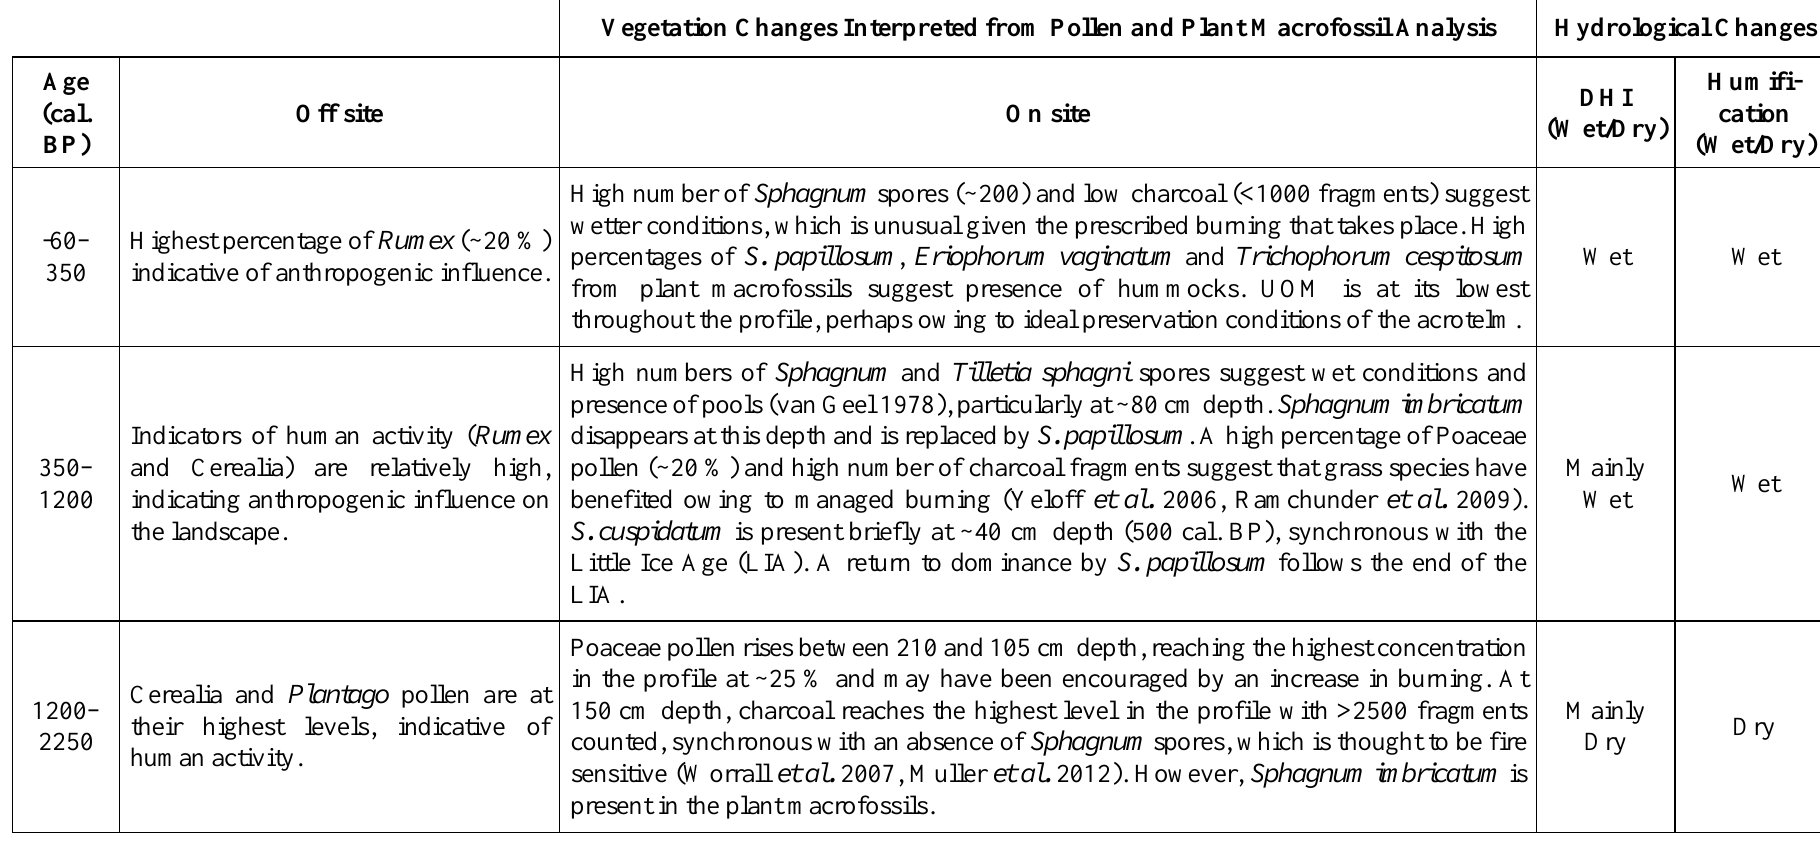
Table 4. On-site and off-site vegetation changes using age (cal. BP), pollen zones, depth (cm), interpretation using pollen, charcoal and plant macrofossil analysis and hydrological changes (DHI and